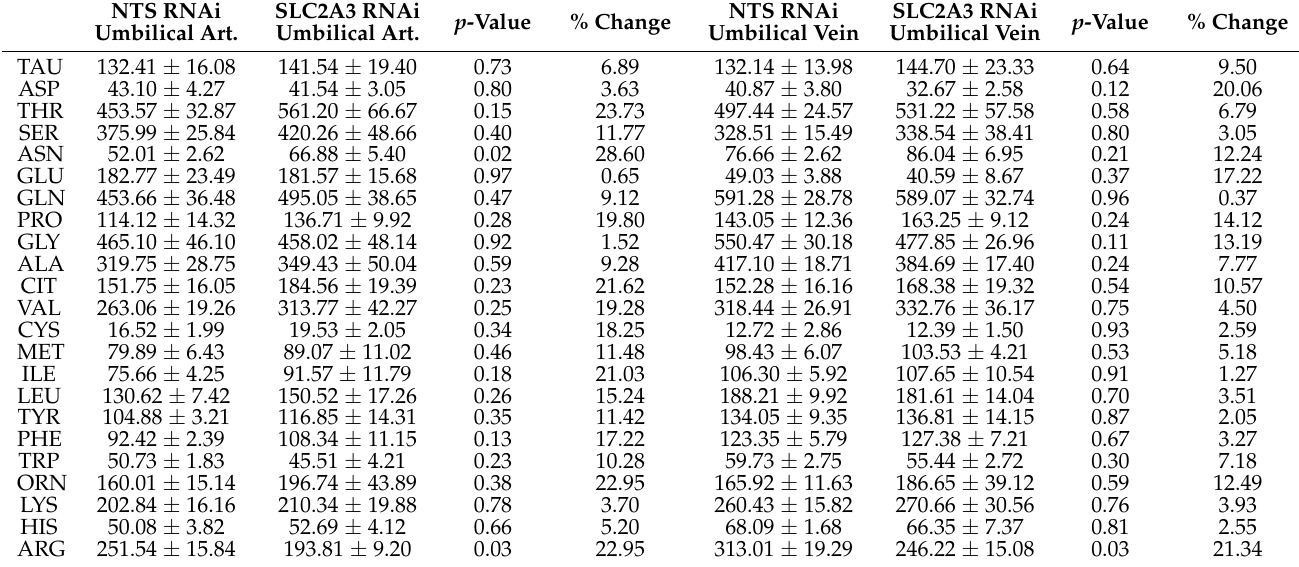
Table 4. Fetal plasma amino acid concentrations (75 dGA).